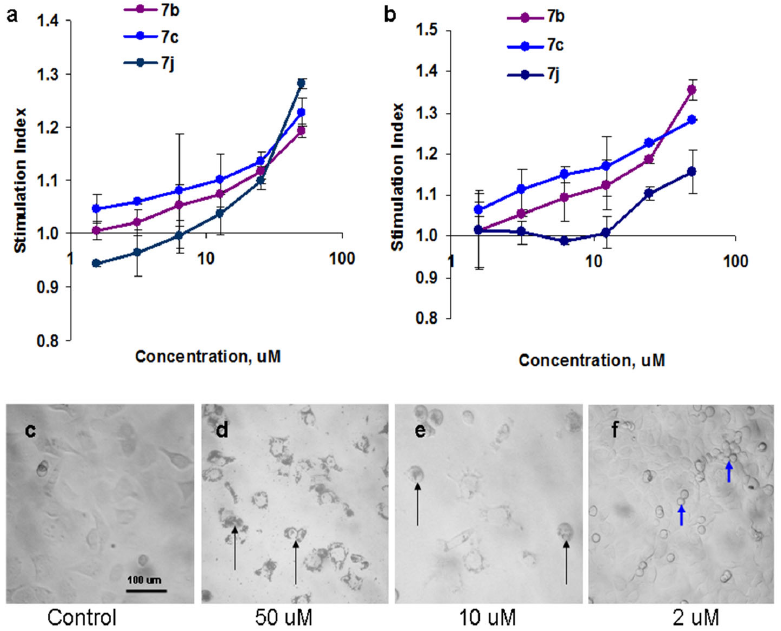
Figure 7. Reactive oxygen species production in the presence of compounds 7 . ( a , b ) SkBr ‐ 3 ( a ) and MCF7 ( b ) ROS production expressed as the ratios of intracellular ROS production by the stimulated cells to the control ones. ( c – f ) Microphotographs of SkBr ‐ 3 cells in the presence of compound 7c . Black arrows show dying cells, blue arrows show unable to duplicate DNA cells.